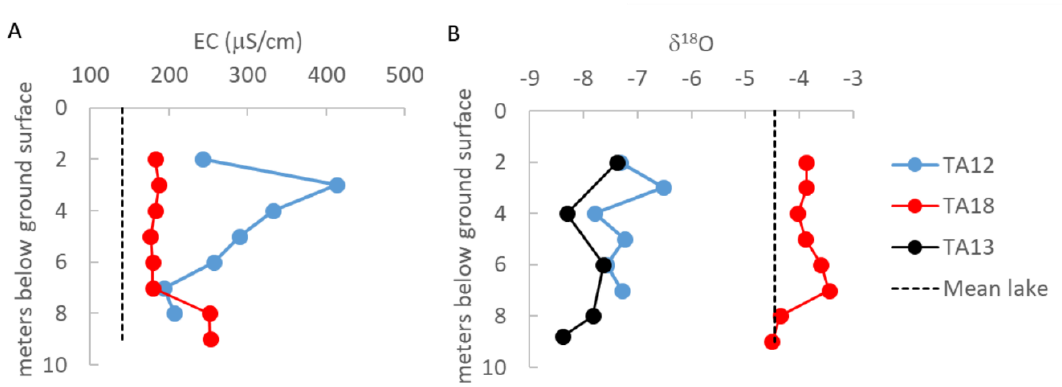
Figure 5. ( A ) EC profiles in wells TA12 and TA18. ( B ) δ 18 O profiles in TA12, TA13, and TA18. TA12 and 13 were sampled on 22–23 June 2015. TA18 was sampled on 22 August